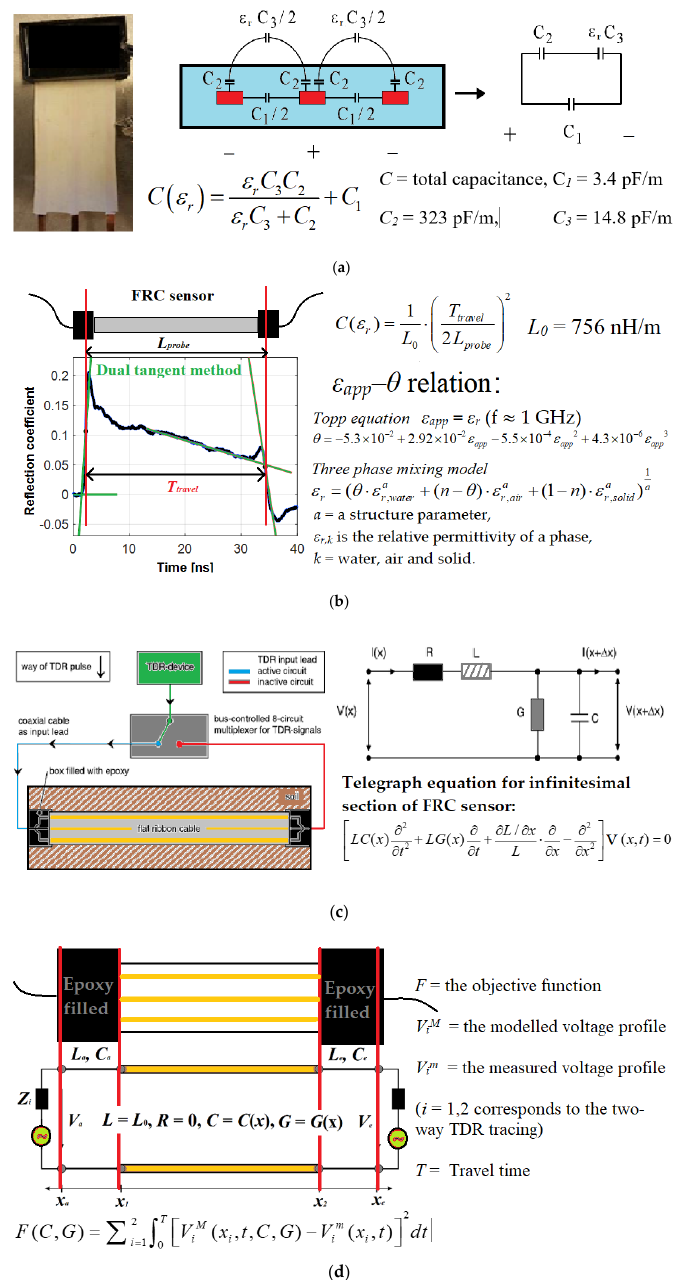
Figure 11. The comprehensive illustration of the spatial TDR technique with the FRC sensor design: ( a ) the FRC sensor design and capacitance model; ( b ) the conventional TDR application using the FRC sensor; ( c ) the illustration of two-way TDR tracing and telegraph equation modelling FRC sen- sor as transmission lines; ( d ) the spatial TDR inversion analysis with an illustration of the optimiza- tion objective function between the measured and modelled TDR waveforms [11,15,69,70]. Similarly to the conventional three-pin TDR sensor, the new designed FRC sensor also has three copper wires as the waveguide. Still, they are insulated by a polyethylene